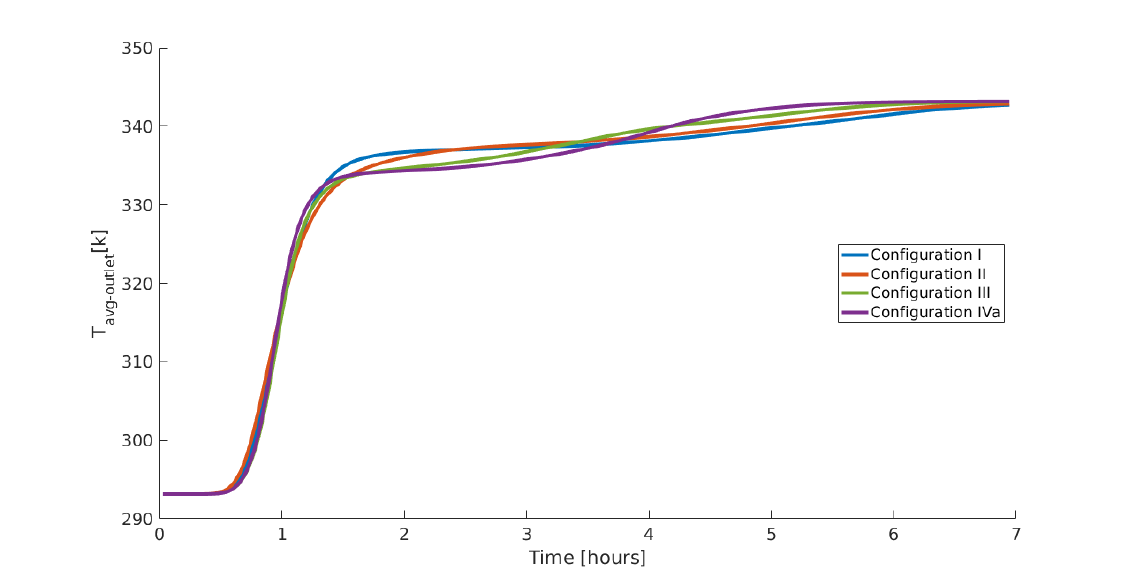
Figure 8. Average outlet